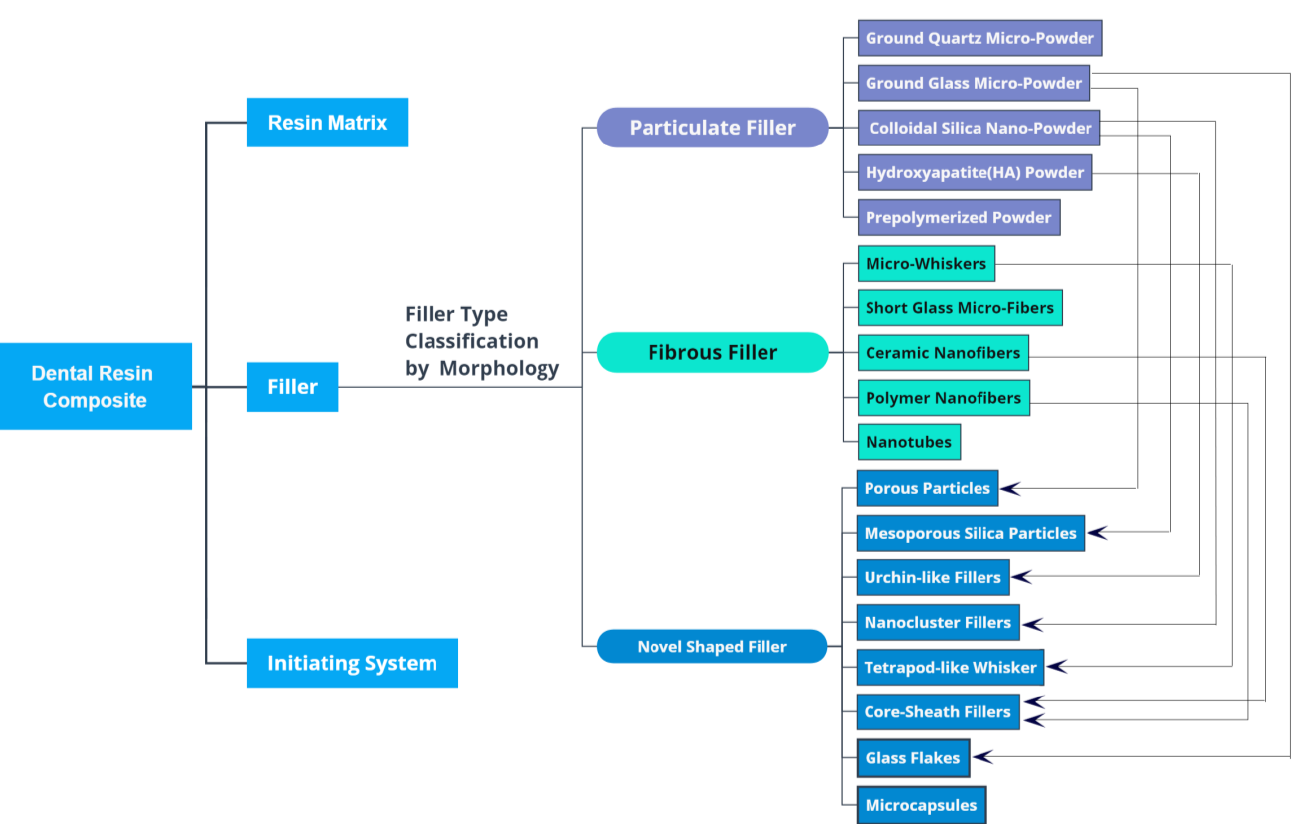
Figure 1. Classification of fillers in dental resin composites. The arrows illustrate the potential interconnections between traditional fillers and novel-shaped fillers.